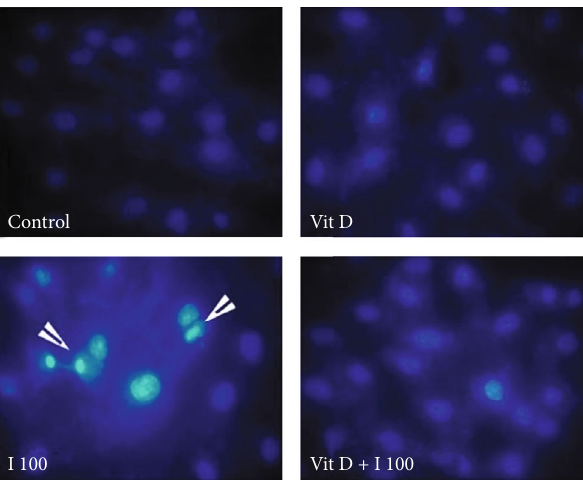
Figure 5: Fluorescent micrographs of Vero cells stained with DAPI (4 ′ ,6-diamidino-2-phenylindole) demonstrating more prominent nuclear condensation (shown in blue) in the iohexol-treated (I100) group (white arrows) compared to the iohexol+vitamin D-treated (Vit D+I100) group. Magni fi cation 100x.